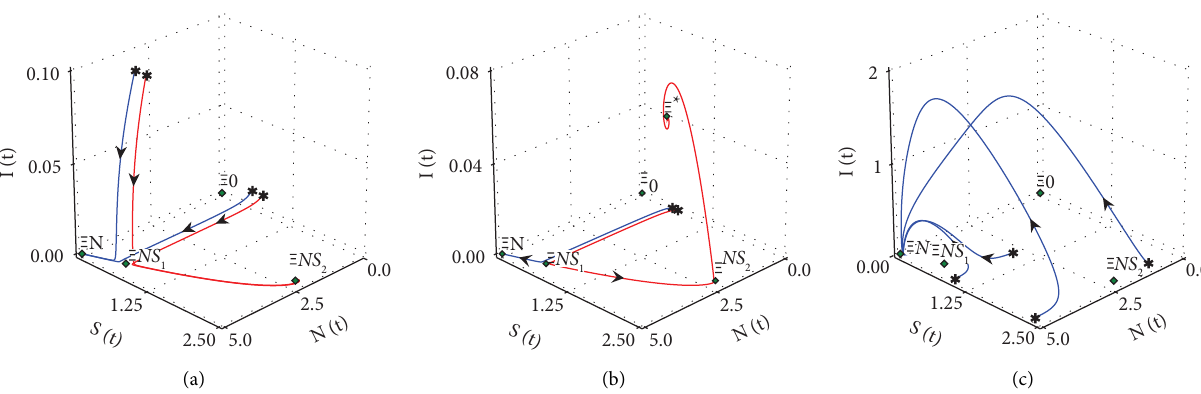
Figure 4: Phase portrait of system (4) for the strong Allee efect case with parameter values (27). (a) β � 0 . 073, (b) β � 0 . 10, and (c) β � 0 .